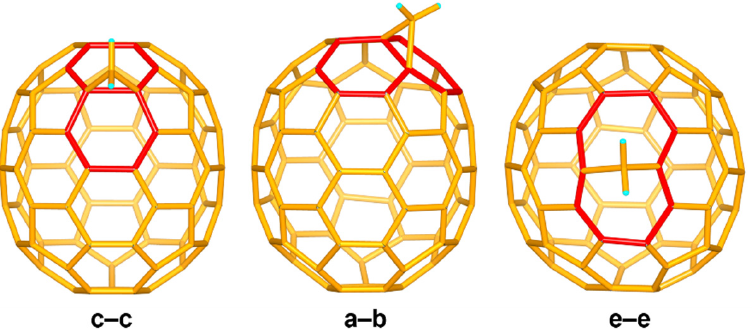
Figure 2. Ball-and-stick models of C 71 H 2 -I ( c–c ), C 71 H 2 -II ( a–b ), and C 71 H 2 -III ( e–e ). C 71 H 2 -I and C 71 H 2 -II are methanofullerenes, C 71 H 2 -III is a homofullerene. The carbene addition sites are highlighted in red.